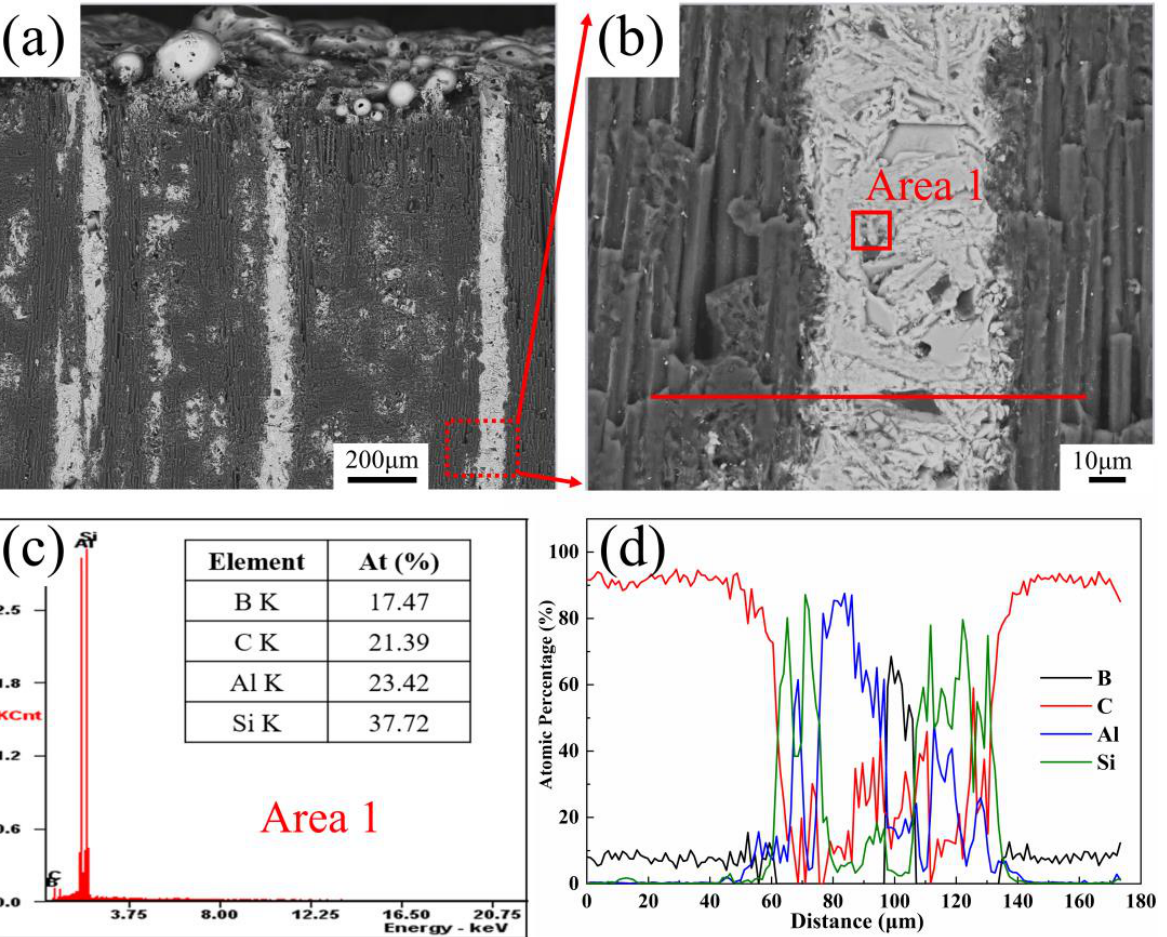
Figure 3. SEM image of the AlSiB-C/C composites ( a , b ), and the EDS analysis results ( c , d ) of Area 1 and the red line, respectively.